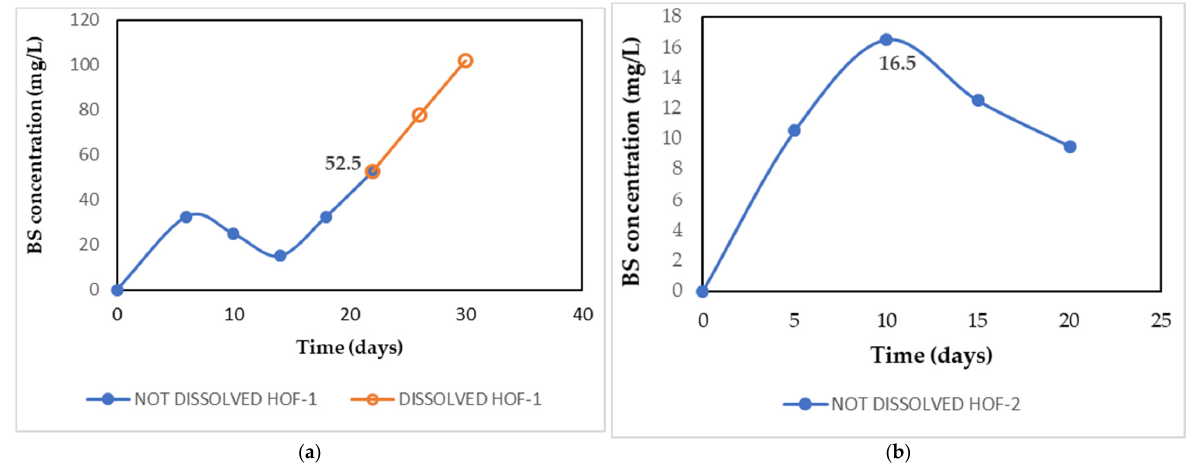
Figure 2. ( a ) Biosurfactant production by A. borkumensis SK2 in ONR7a with HOF-1 as carbon source and N and P nutrients (filled dots ● ); 52.5 mg/L is the maximum amount of BS reached without impurities in the product; after that, the product is contaminated by the carbon source (empty dots o ). ( b ) Biosurfactant production by A. borkumensis SK2 in ONR7a with HOF-2 as the carbon source and N and P nutrients.